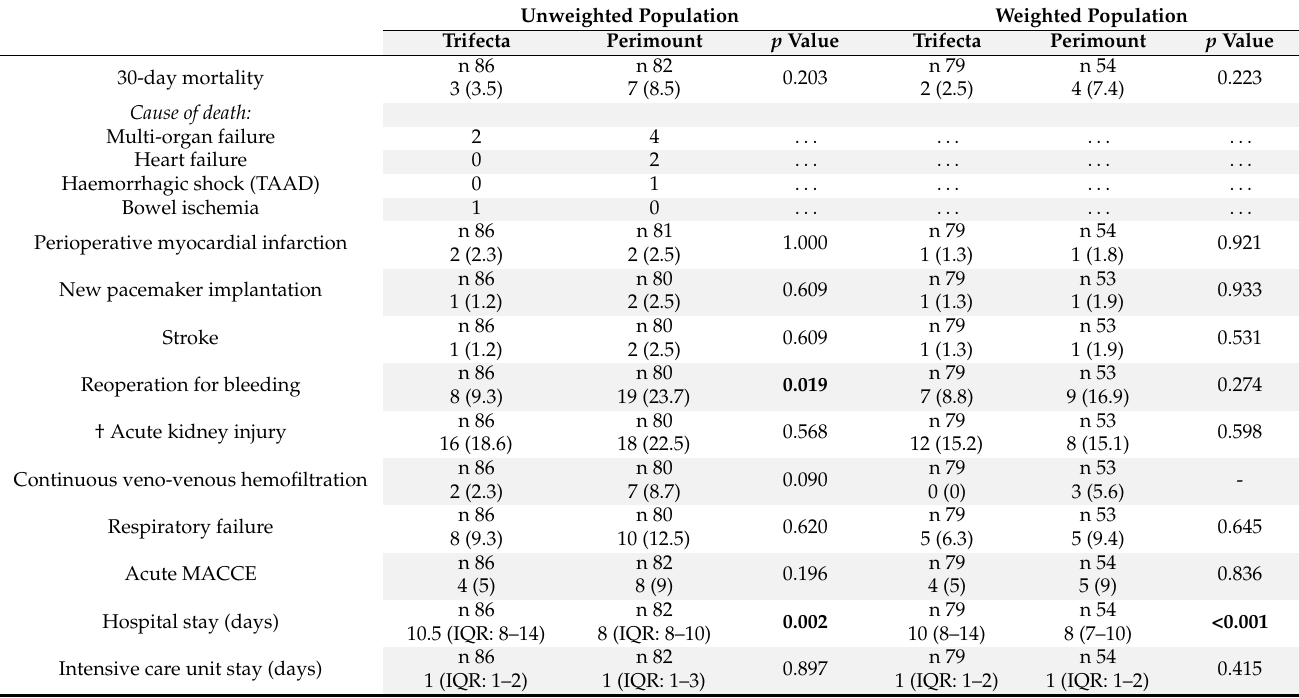
Table 3. Hospital outcome.